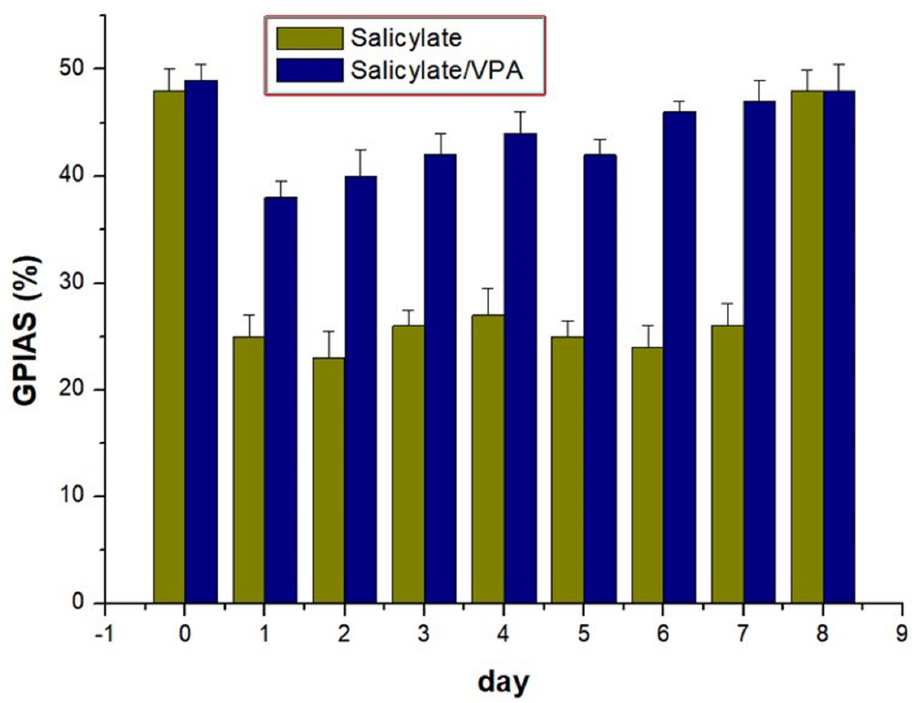
Figure 5. The salicylate/VPA group showed significantly attenuated GPIAS ratio compared with that in the salicylate group from days 1 to 7 (days 1–4, p < 0.05; days 5–7, p < 0.01).